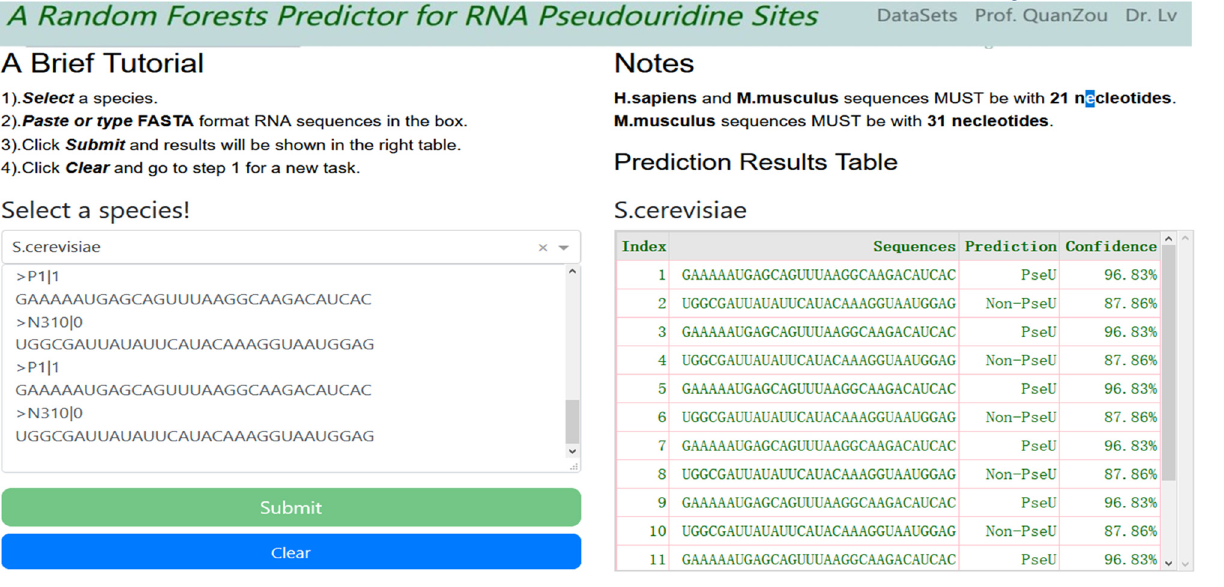
FIGURE 3 | A screenshot of RF-PseU web server interface. The web server allows users to type or paste FASTA format text into the textbox and click submit button; the results are displayed in the right-hand table.